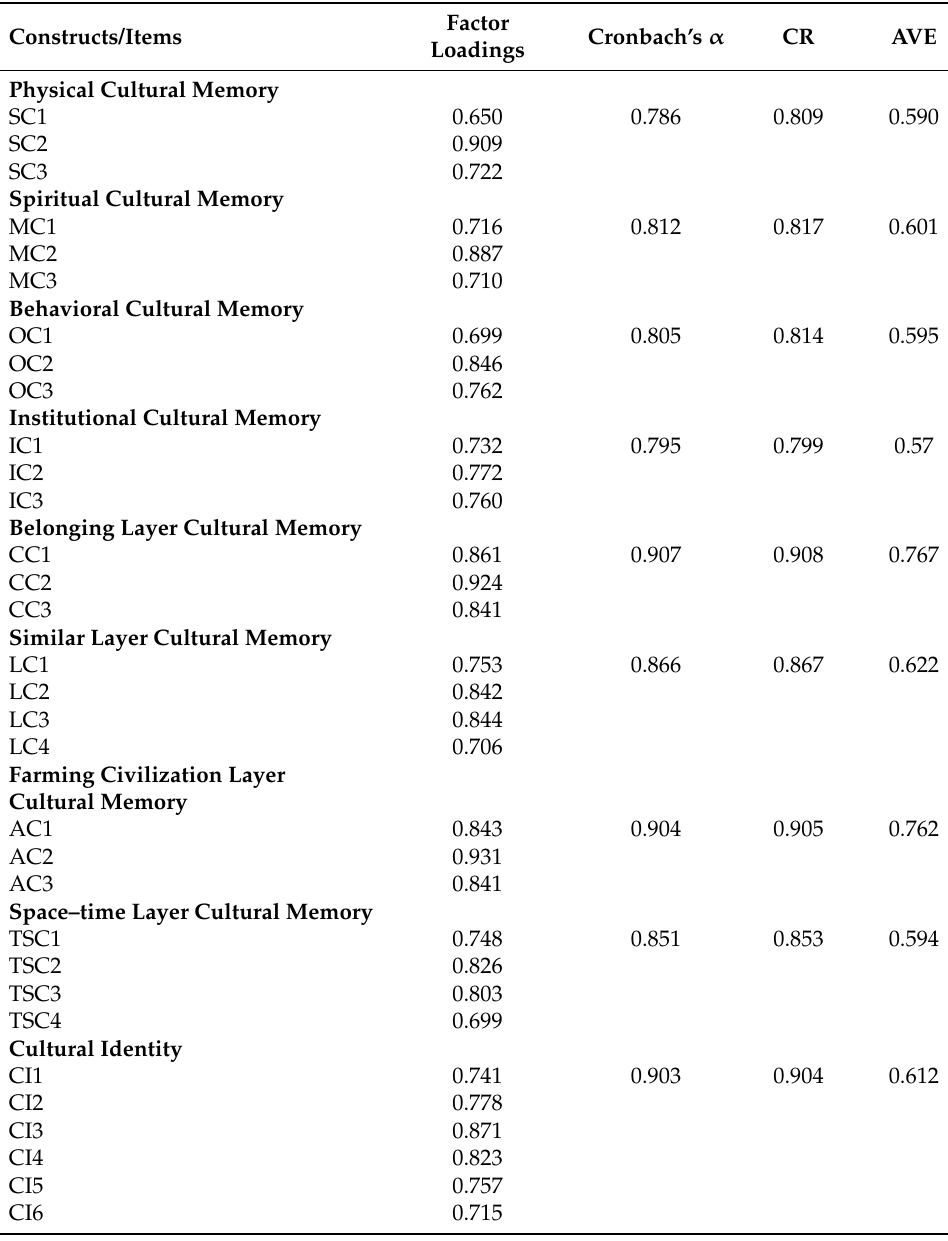
Table 4. Reliability and convergence